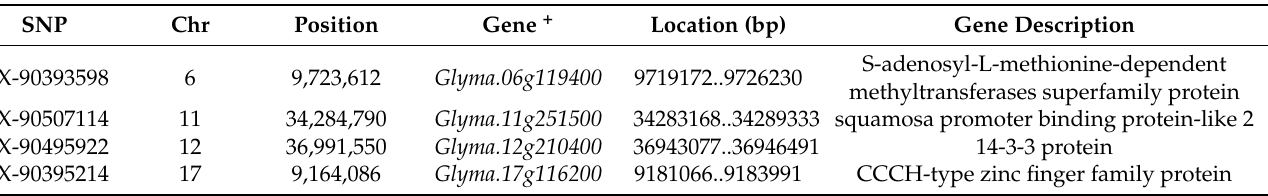
Table 5. Candidate genes associated with DtF in wild